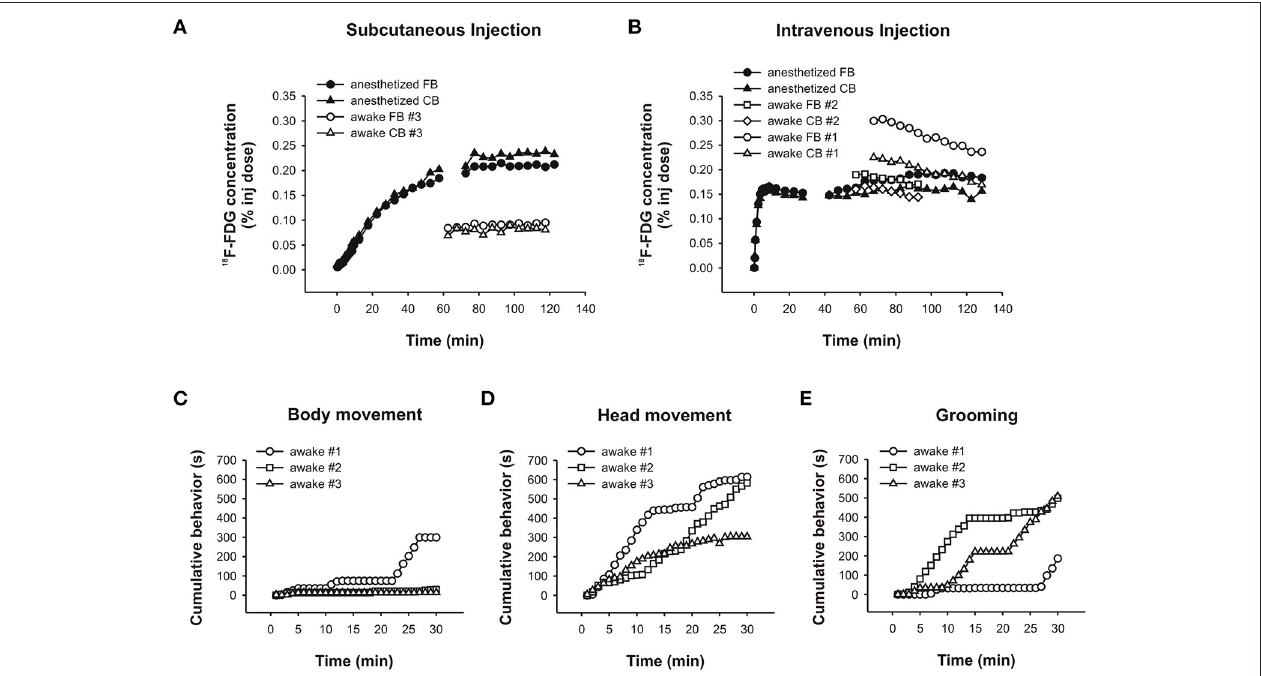
FIGURE 9 | PET data and behavioral analyses for the chicken. Time-activity curves for the chicken following a (A) subcutaneous injection of 18 F-FDG showing an anesthetized (black symbols) and an awake (white symbols) uptake study. Circles and triangles show uptake in the forebrain and cerebellum, respectively. (B) Intravenous injection of 18 F-FDG showing an anesthetized (black symbols) and two awake (white symbols) uptake experiments. Circles and squares show uptake in the forebrain, and triangles and diamonds show uptake in the cerebellum. The time-activity curves for the anesthetized animal is shown in two parts due to subject motion midway through the scan. Durations (s) of (C) body movement, (D) head movement and (E) grooming were summed for each 1min time bin and cumulated. The rank order of chickens spending time engaging in each behavior changed when the initial 5–10min were considered versus the entire 30min of 18 F-FDG